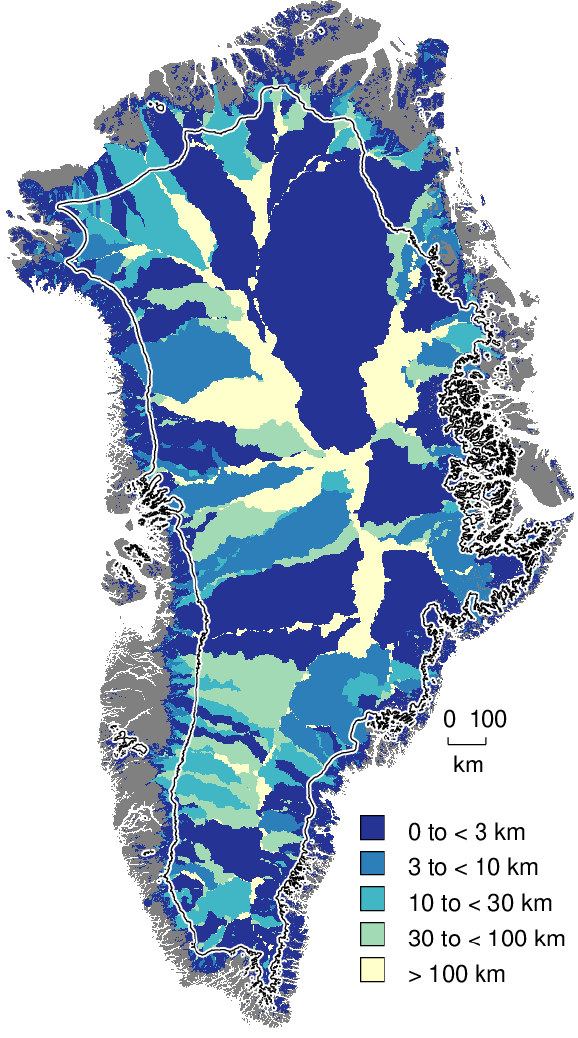
Figure 2. Basin changes with changing k . Map of Greenland show- ing maximum of all possible distances among outlet cell loca- tions for all upstream cells, based on three effective basal pressure regimes ( k ∈ [ 0 . 8 , 0 . 9 , 1 . 0 ] , Eq. 2). Contour line shows 1500m ele- vation contour – most runoff occurs below this